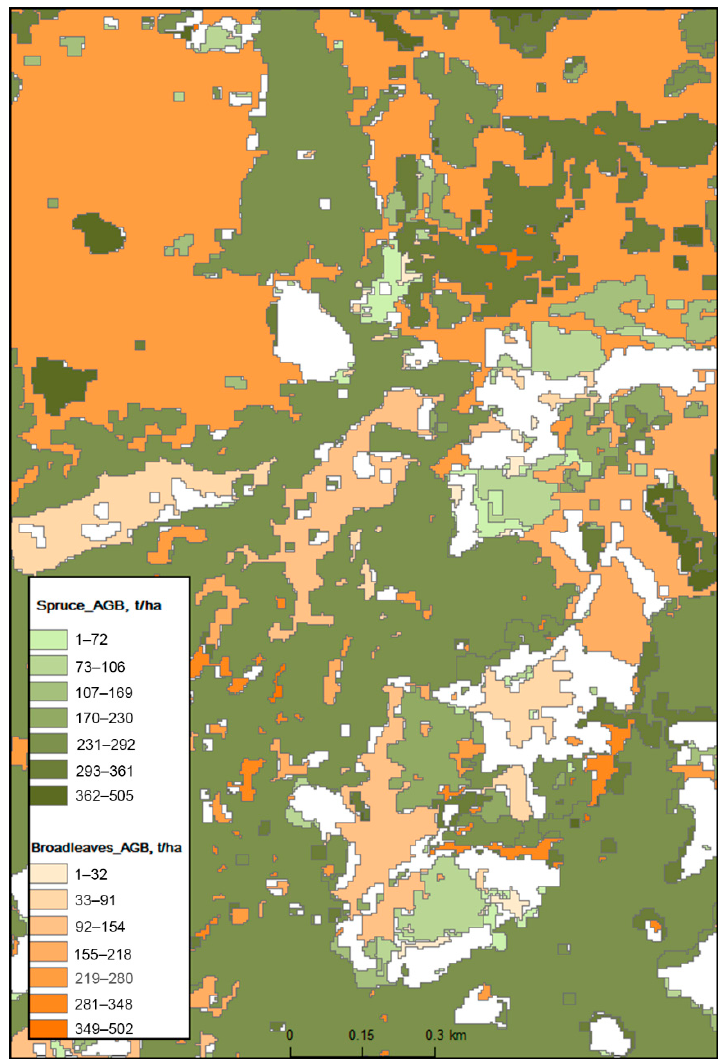
Figure 4. Map of forest aboveground biomass developed by the plot-level method from a fusion of hyperspectral and LiDAR data (Beskydy Mountains, Czech Republic). Adapted from (Brovkina et al., 2016).